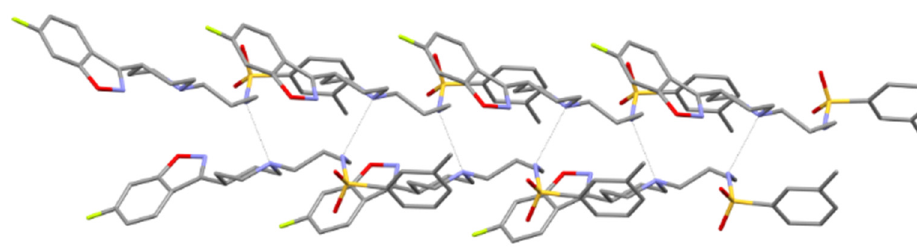
Figure 2. The intermolecular hydrogen bonds in MBS . Table 2. Hydrogen-bond geometry (Å, °) for 1.